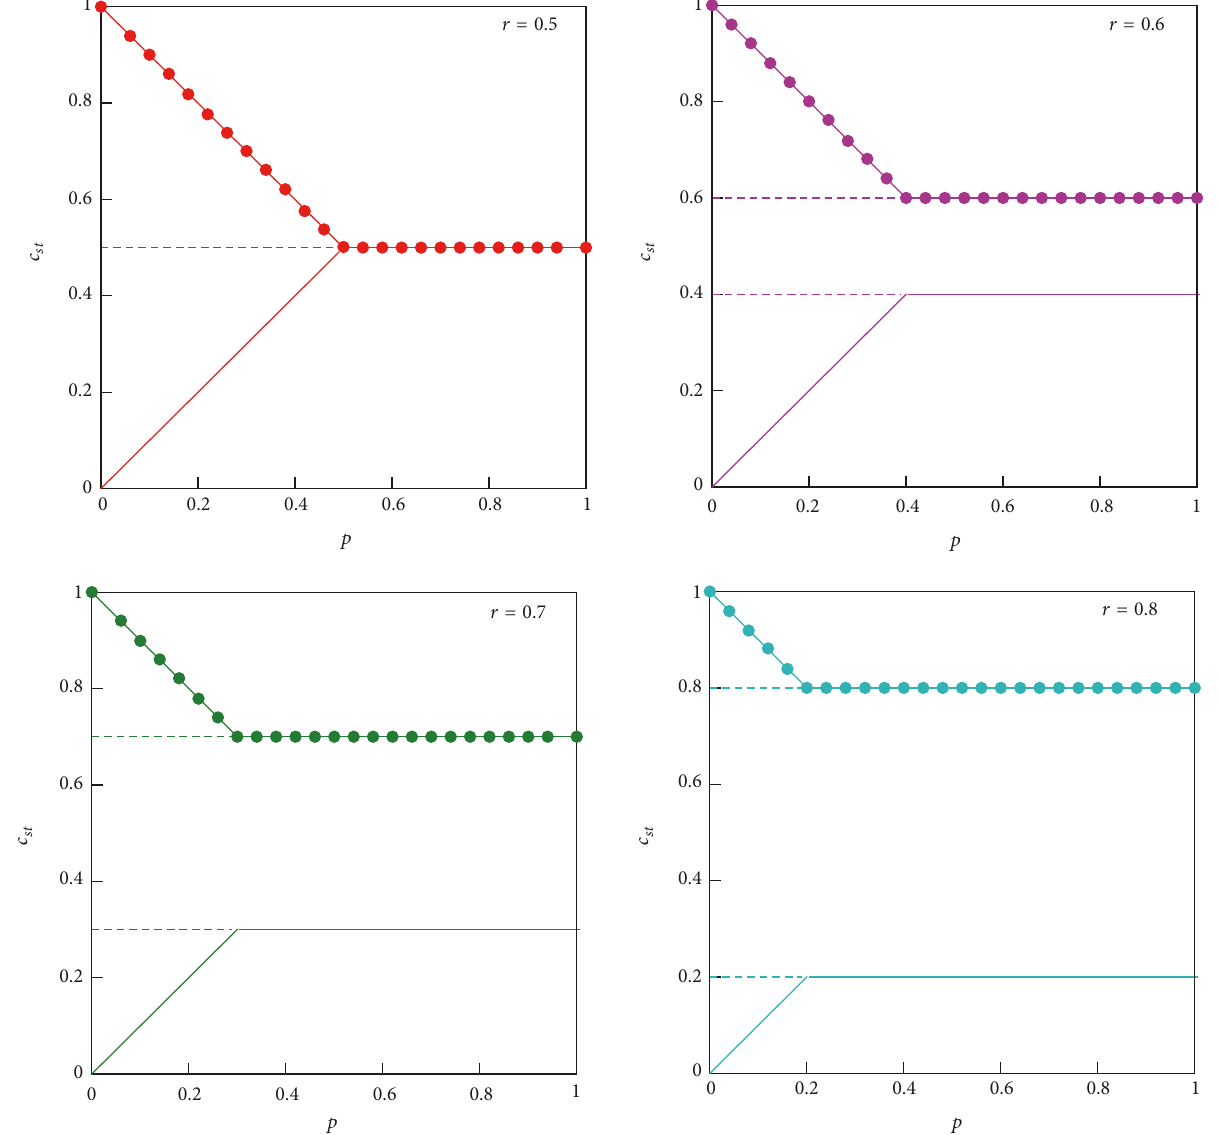
Figure 2: Phase diagrams for the model with anticonformity for different values of the threshold 𝑟 . Lines indicate the analytical prediction from MFA and dots represent results of the Monte Carlo simulations from the initial fully ordered state ( 𝑐(0) = 1 ) for the system of size 𝑁 = 5 ⋅ 10 4 .